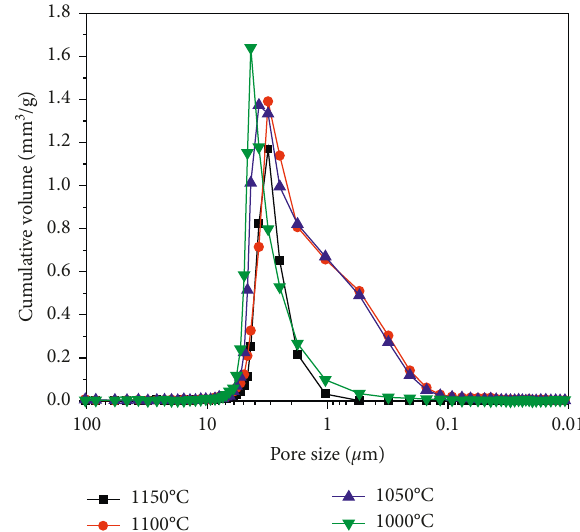
Figure 13: Influence of the sintering temperature on the pore size and distribution in the porous ceramics.